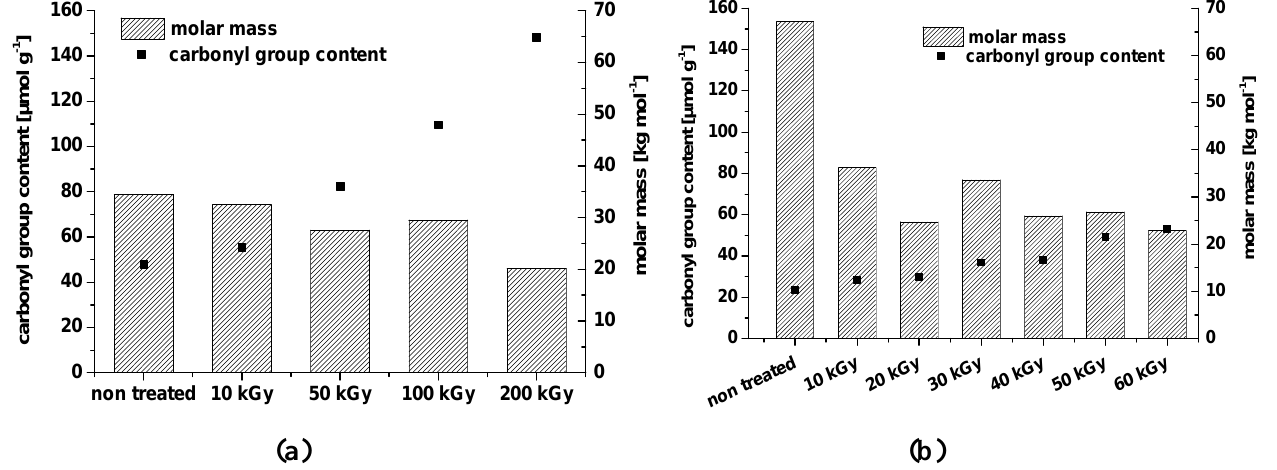
Figure 2. Weight average molar mass and carbonyl group content of microcrystalline cellulose ( a ) and nanocrystalline cellulose (( b ) dry irradiation) after treatment with